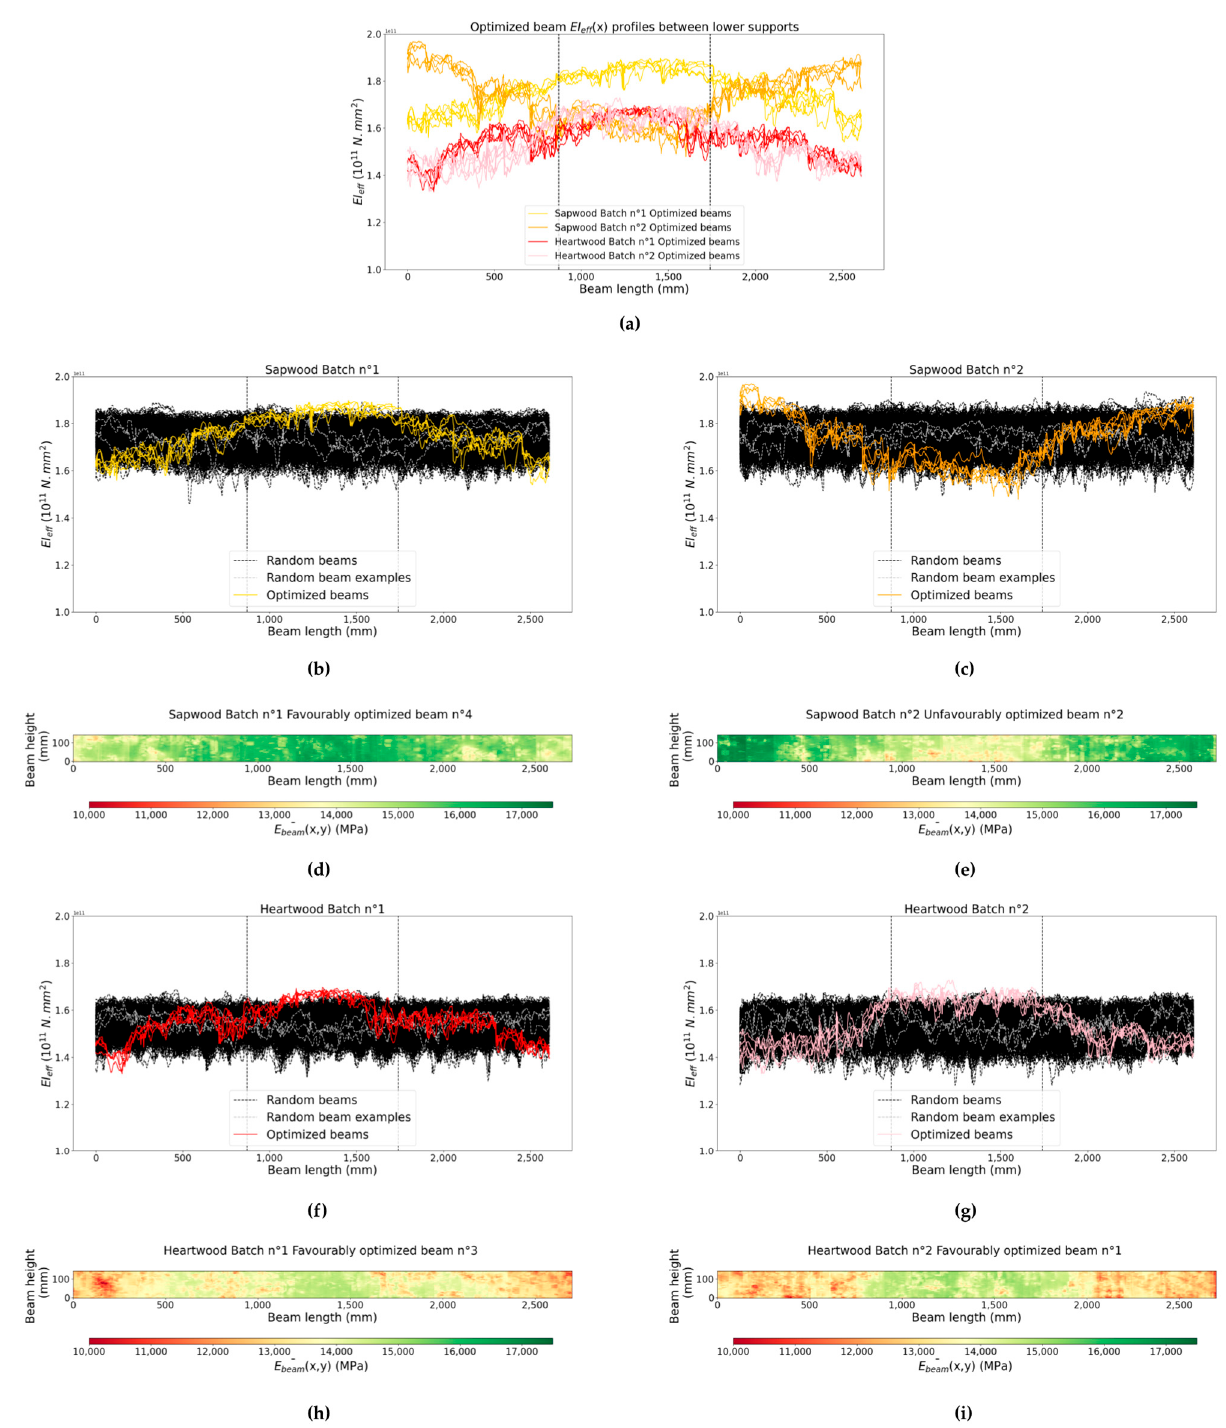
Figure 6. Beam EI ef f profiles: ( a ) optimized beams from the four batches, ( b ) batch n ◦ 1 sapwood beams among random Figure 6. Beam 𝐸𝐼 (cid:3032)(cid:3033)(cid:3033) profiles: ( a ) optimized beams from the four batches, ( b ) batch n°1 sapwood beams among random beams, ( c ) batch n ◦ 2 sapwood beams among random beams, ( f ) batch n ◦ 1 heartwood beams among random beams, ( g ) batch beams, ( c ) batch n°2 sapwood beams among random beams, ( f ) batch n°1 heartwood beams among random beams, ( g ) n ◦ 2 heartwood beams among random beams. Beam E beam ( x , y ) grid: ( d ) batch n ◦ 1 sapwood beam, ( e ) batch n ◦ 2 sapwood batch n°2 heartwood beams among random beams. Beam 𝐸 (cid:3029)(cid:3032)(cid:3028)(cid:3040) (cid:3364)(cid:3364)(cid:3364)(cid:3364)(cid:3364)(cid:3364)(cid:3364)(cid:3364)(cid:4666)𝑥, 𝑦(cid:4667) grid: ( d ) batch n°1 sapwood beam, ( e ) batch n°2 sapwood beam, ( h ) batch n°1 heartwood beam, ( i ) batch n°2 heartwood beam. beam, ( h ) batch n ◦ 1 heartwood beam, ( i ) batch n ◦ 2 heartwood